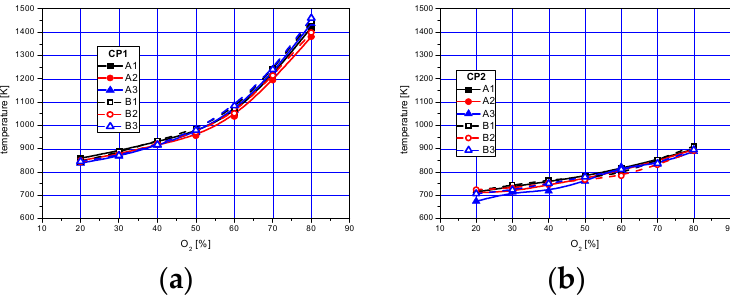
Figure 4. Changes in averaged values of temperature in the planes CP1 ( a ) and CP2 ( b ) for variants A1, A2 , A3 , B1 , B2 , B3 .